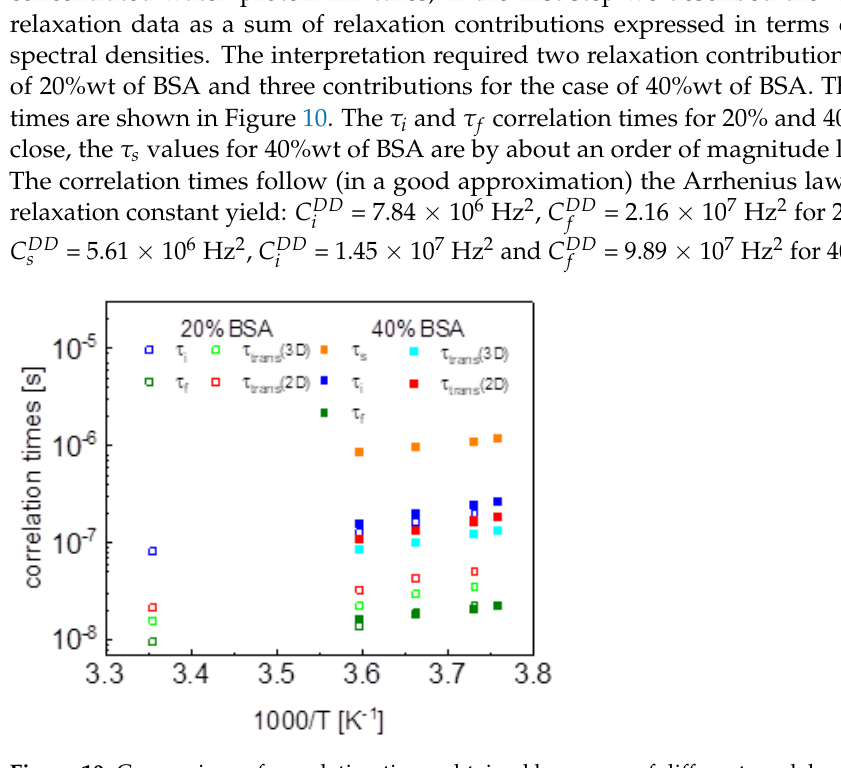
Figure 10. Comparison of correlation times obtained by means of different models.